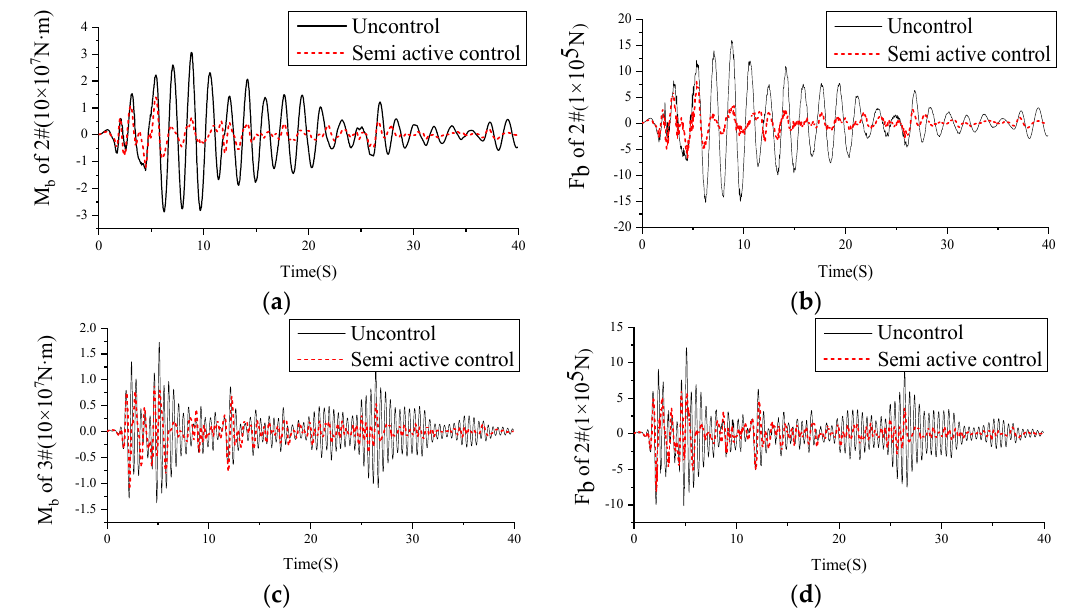
Figure 7. Time history curve of pier internal force under El Centro seismic wave: ( a ) #2 pier bottom bending moment time–history curve; ( b ) #2 pier bottom shear time–history curve; ( c ) #3 pier bottom bending moment time–history curve; ( d ) #3 pier bottom shear force time–history curve.